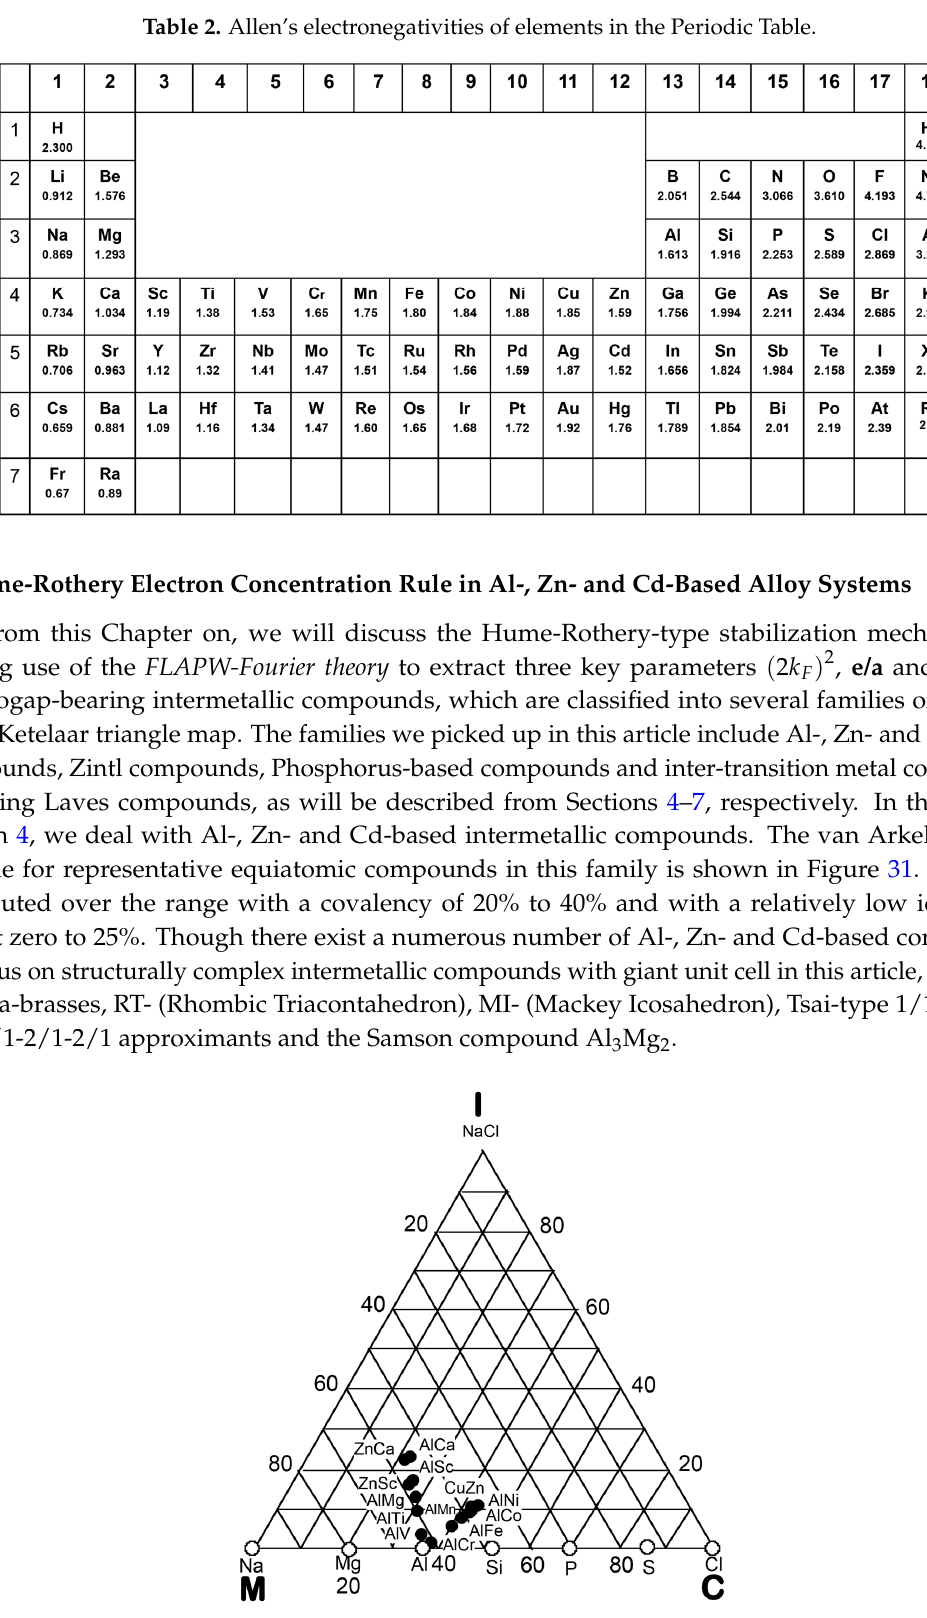
Figure 31. Van Arkel-Ketelaar triangle map for Al-, Zn- and Cd-based equiatomic compounds. It was constructed by inserting Allen’s electronegativity data (Table 2) into Equations (17) and (18) [12].